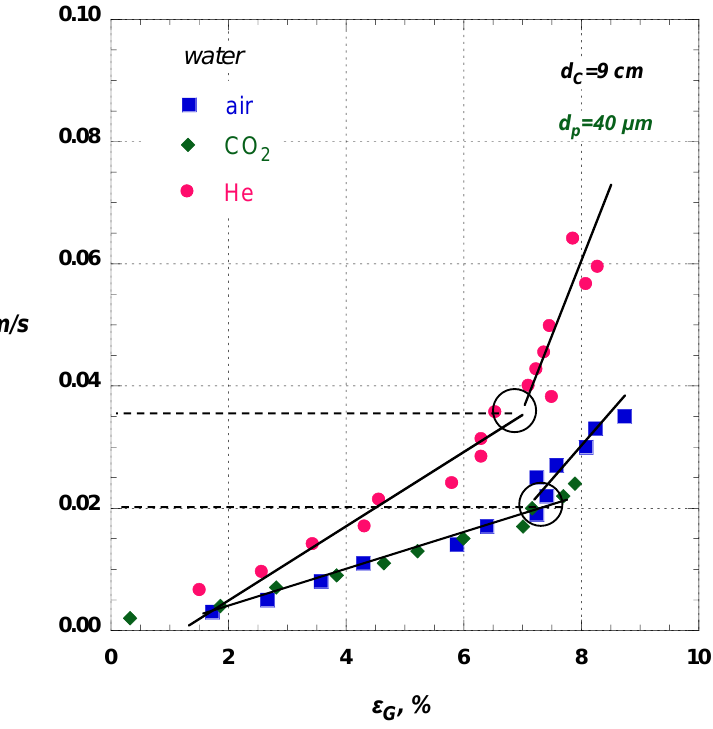
Figure 5. Effect of type of gas on regime transition for water ( d p = 40 μm, d c = 9 cm).